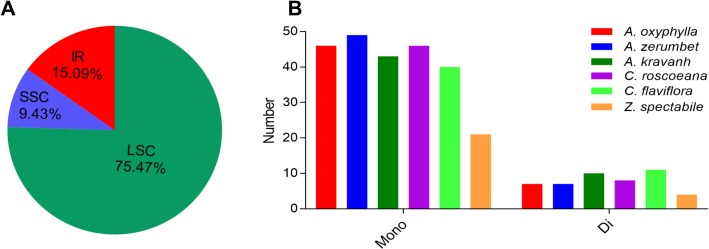
SSR analysis of the six Zingiberaceae chloroplast genomes.(A) Presence of SSRs in the LSC, SSC and IR regions (A. oxyphylla); (B) Presence of polymers in the chloroplast genome of A. oxyphylla, A. zerumbet, A. kravanh, C. roscoeana, C. flaviflora, and Z. spectabile.